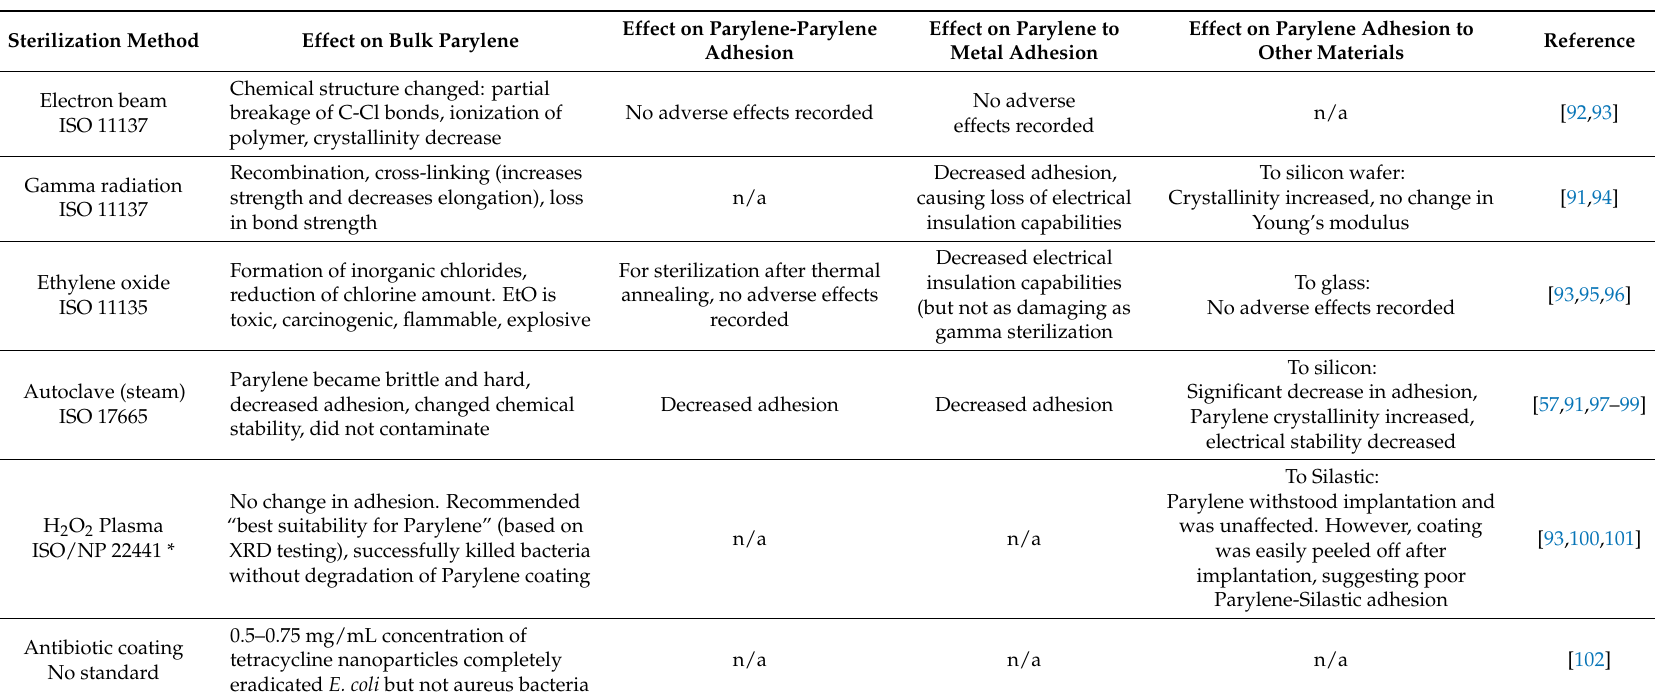
Table 2. Sterilization methods used and their effect on Parylene. “No adverse effects recorded” indicates the sterilization method was used in literature but no adverse effects on adhesion or bulk properties was recorded, while “n/a” indicates no use of the sterilization method was found in